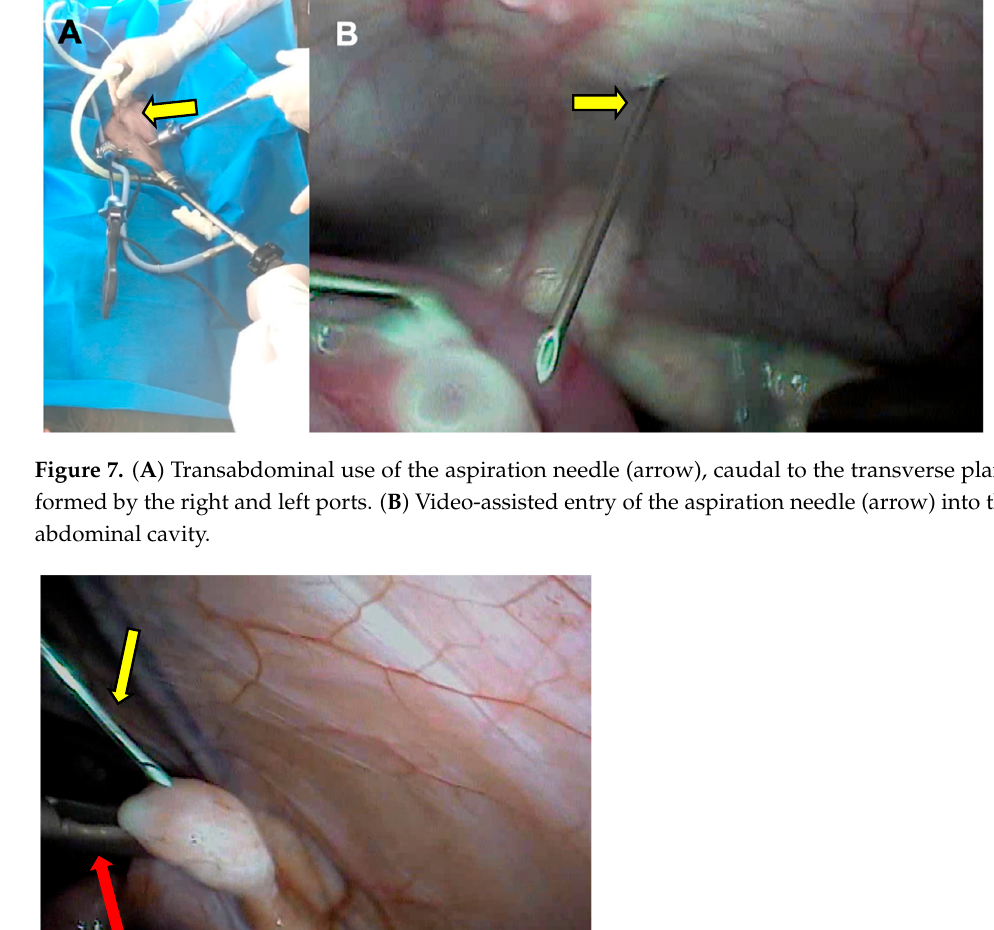
Figure 6 . Distribution of time spent in the steps of the LOPU procedure. Anesthetic and antisepsis procedure (AA); establishment of laparoscopic ports (PE); ovarian manipulation and aspiration (OM); washing, deflation, and suturing (DS) Different letters indicate differences between observations ( p < 0.05).